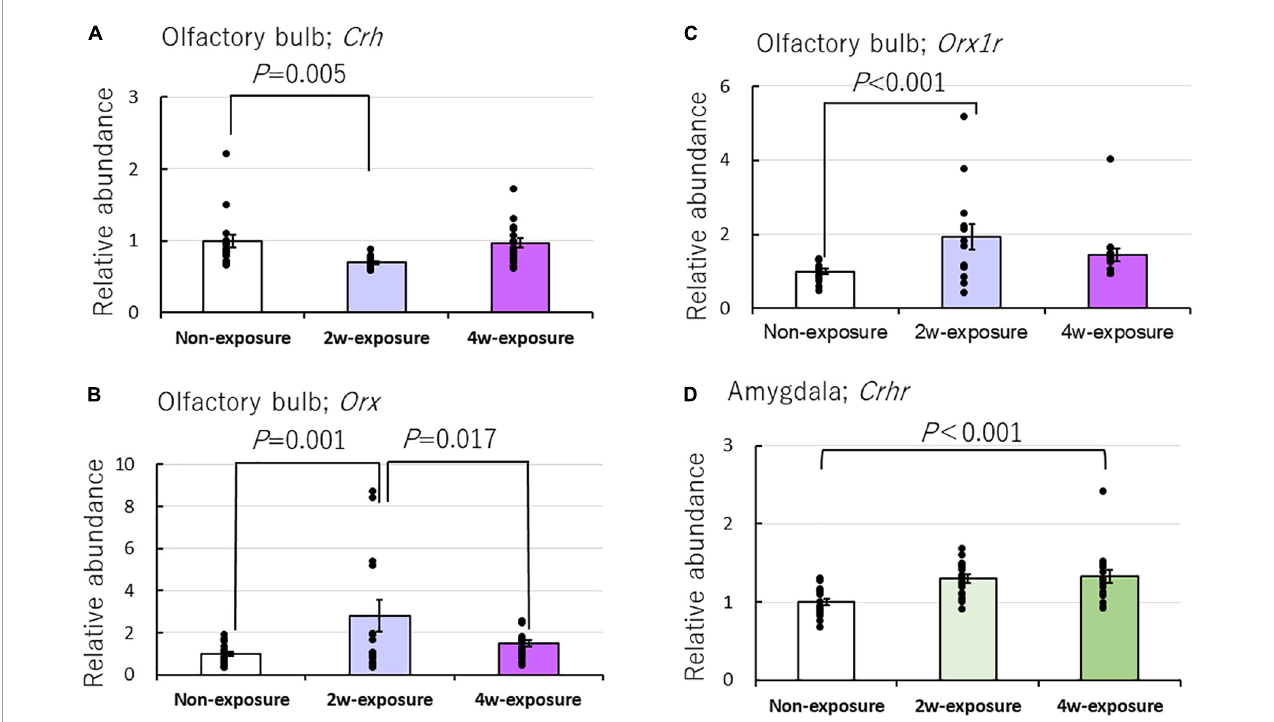
FIGURE6 Effects of repeated coffee odor exposure on gene expression in the olfactory bulb and amygdala. Effect of odor stimulation on the mRNA expression of (A) Crh , (B) Orx , (C) Orx1r in the olfactory bulb, and (D) Crhr in the amygdala. Black dots describe individual data. Data show the mean ± standard error (SE). The statistical significance of the difference between genes in the non-exposure, 2-week, or 4-week exposure groups was tested by two-factor ANOVA followed by a Bonferroni post-hoc test. A P -value of < 0.05 was considered statistically